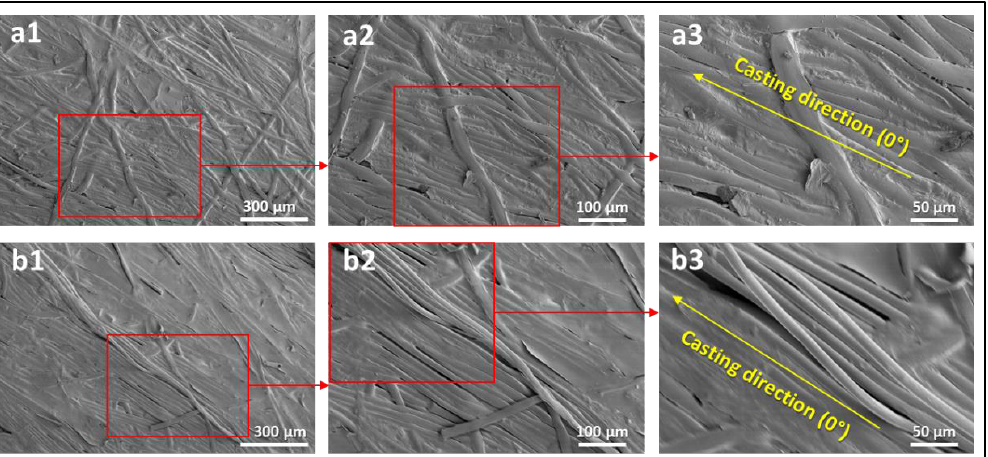
Figure 6. SEM images of ( a1 – a3 ) unloaded polyester and ( b1 – b3 ) loaded polyester near the fracture region.